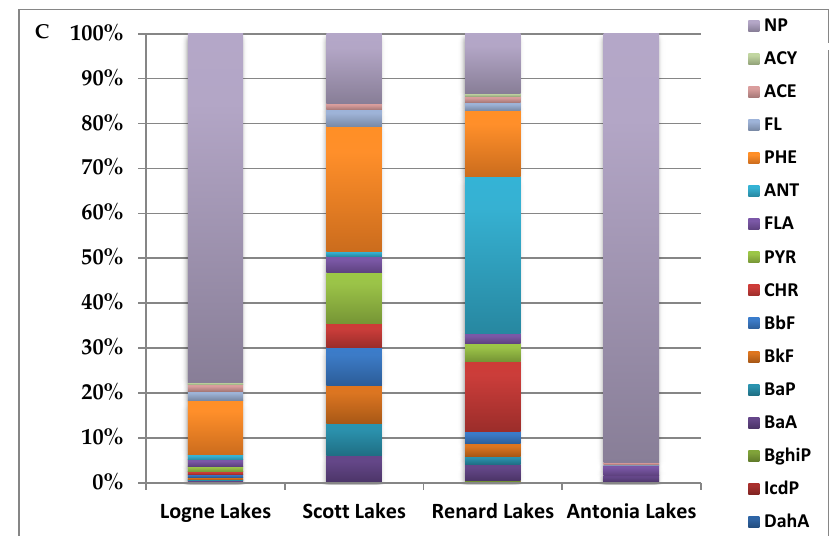
Figure 3. Distribution of detected Polycyclic Aromatic Hydrocarbons (PAH) compounds in studied water samples: ( A ) , ( B ) — differences in mean concentration; ( C ) — percentage contribution in the mean value of the Σ 16 PAHs.